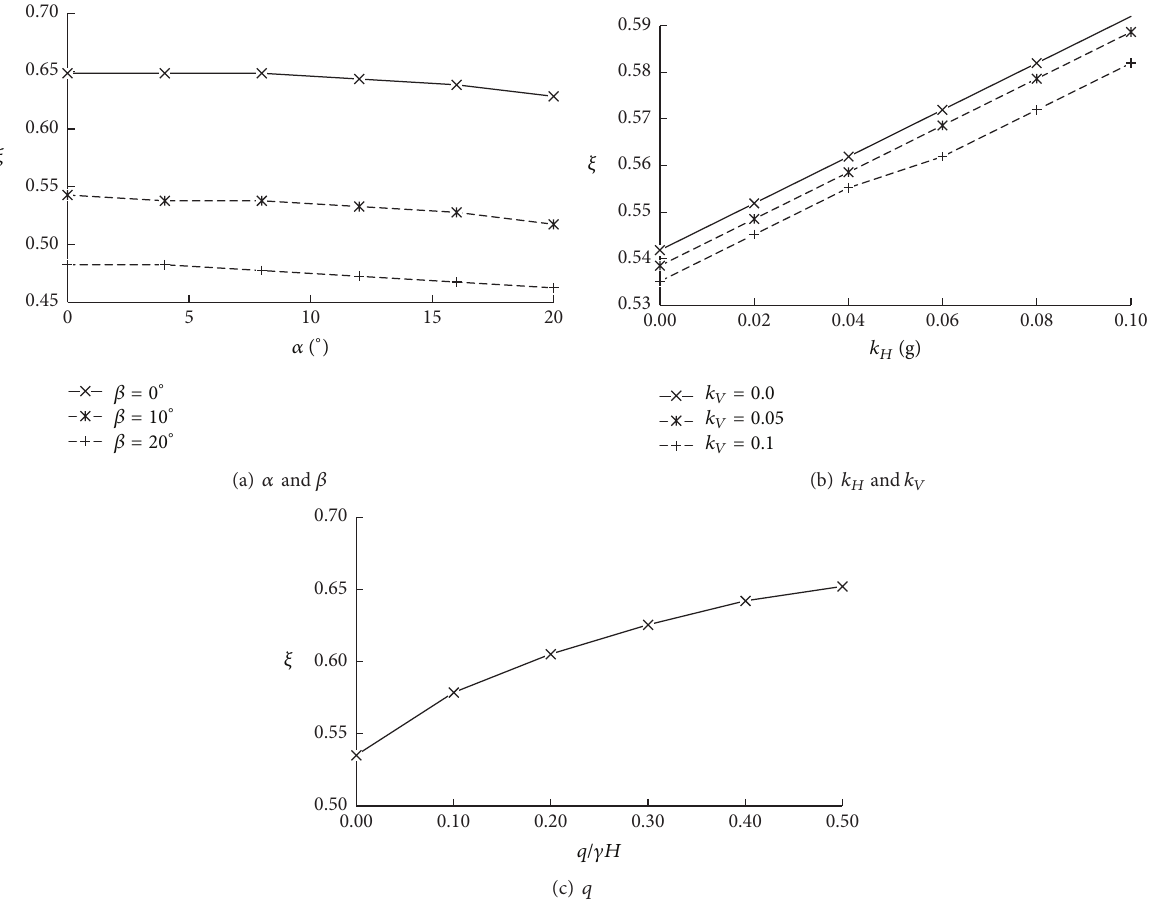
Figure 6: Effects of relevant parameters on 𝜉